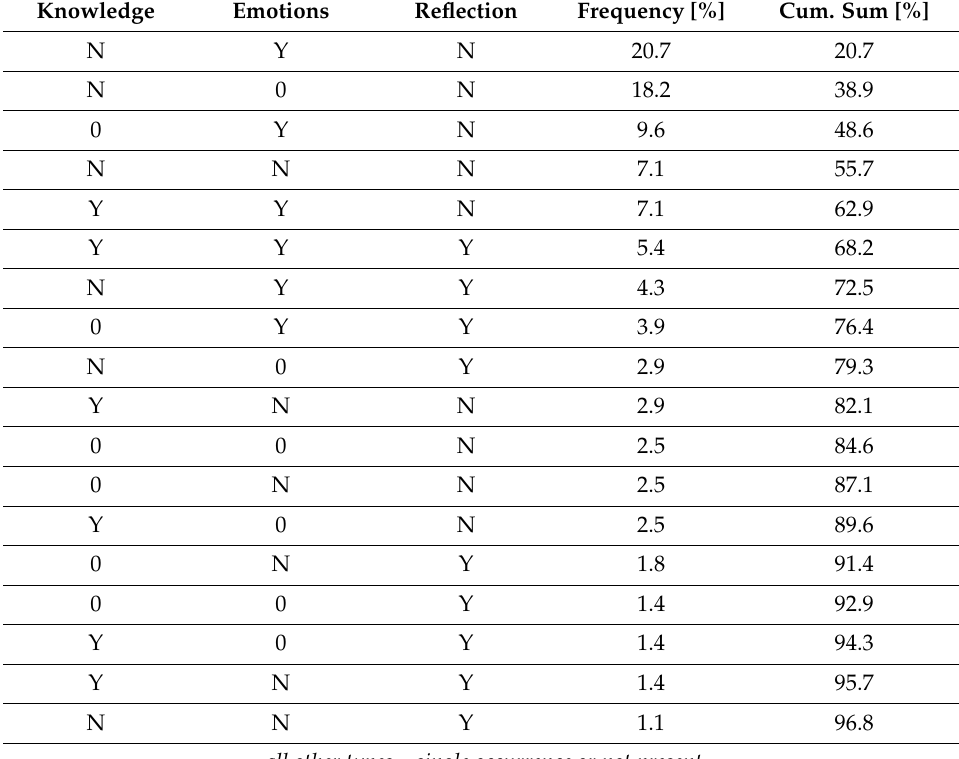
Table 2. Attitude types used in the